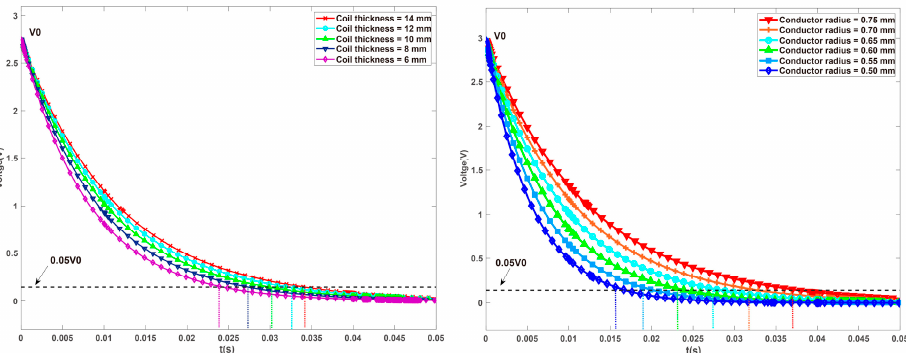
Figure 16. The effect of coil thickness and copper wire diameter on response time. Figure 16. The e ff ect of coil thickness and copper wire diameter on response time. Table 7. Allowable values of the design variables for The coil thickness ( 𝐶 (cid:3045) ) and copper wire diameter ( 𝐶 (cid:3031) ) were selected as design varia-